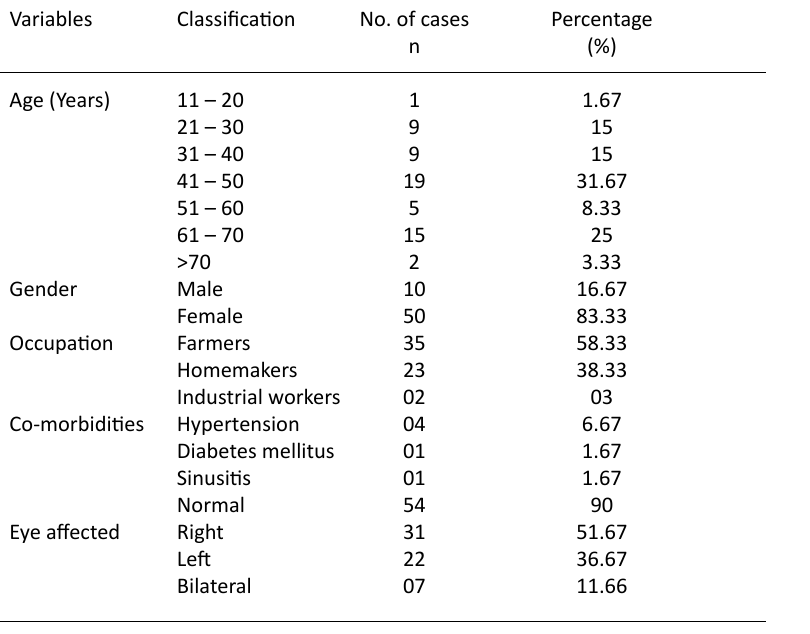
Table 1. Distribution of chronic dacryocystitis cases according to socio-demographic profile (n =